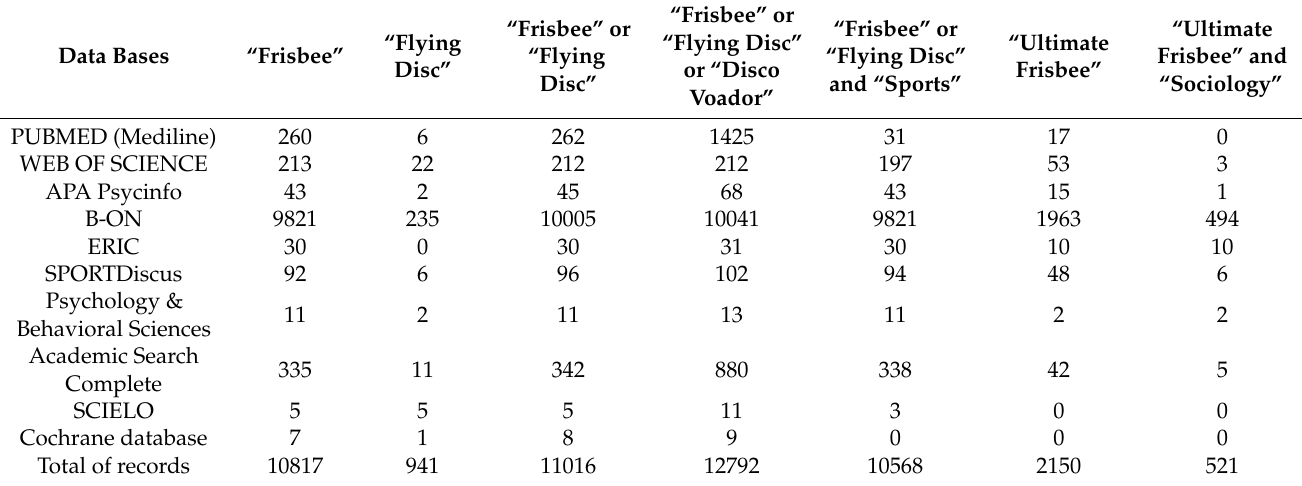
Table 1. Search terms used depending on the different databases and the number of articles generated in the pilot search.